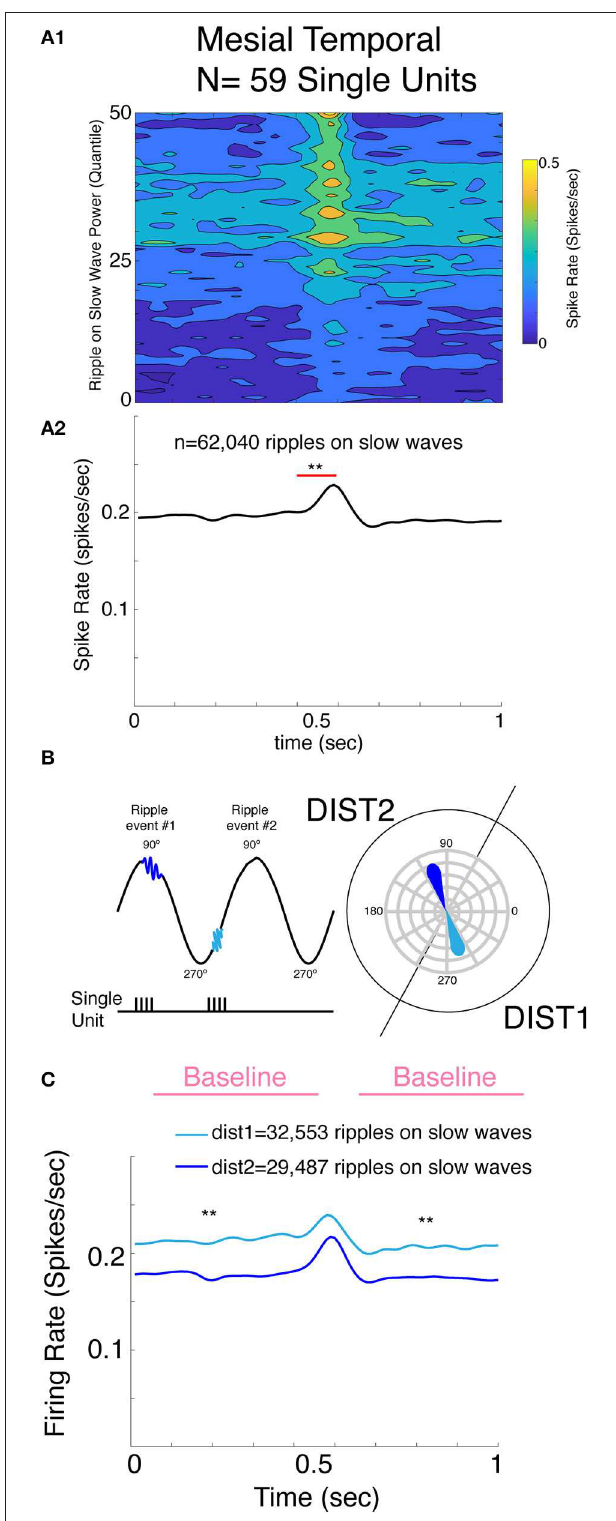
FIGURE 3 | Mesial temporal lobe single unit spiking increases proportional to the RoSW power recorded from the adjacent macroelectrode, and units